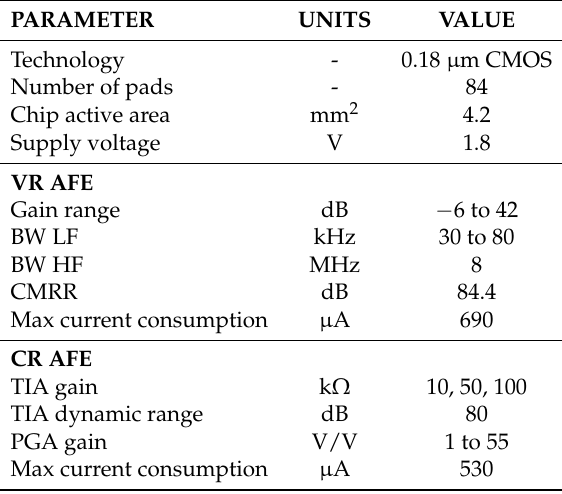
Figure 17. EIS AFE chip microphotograph. Table 1. Summary of chip measured